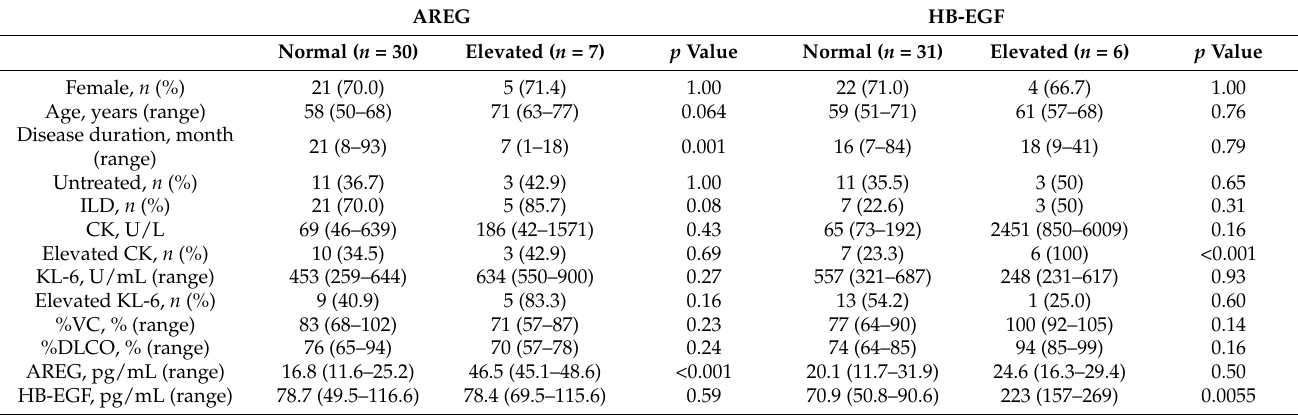
Table 2. Clinical and laboratory parameters in IIM patients with or without elevated serum AREG/HB-EGF